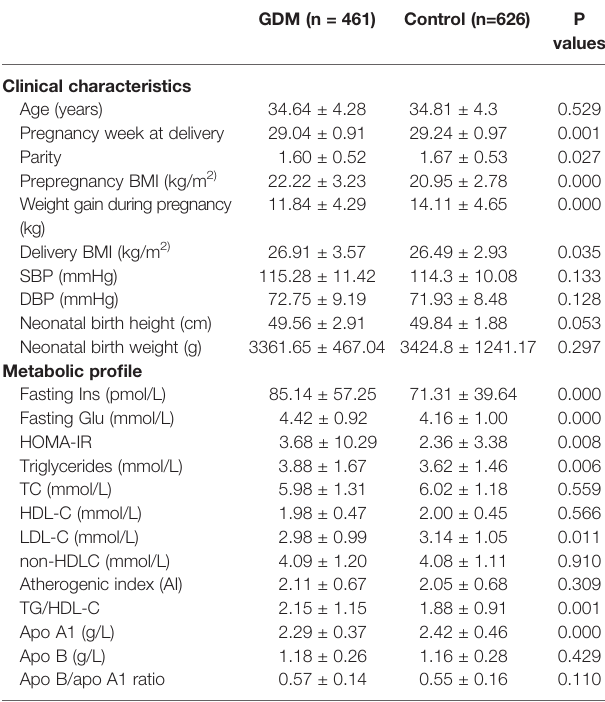
TABLE 1 | Clinical and biochemical characteristics in patients with GDM and control women.